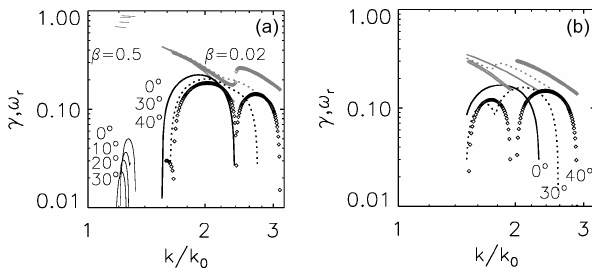
Figure 1. Solutions of the dispersion equation (growth rates in black and frequencies in gray) versus normalized wavenumber for right- handed (a) and left-handed (b) polarized Alfvén pump waves at propagation angles 0, 30, and 40 ◦ and plasma β = 0 . 02. (a) also shows the result obtained for right-hand polarization and plasma β = 0 .